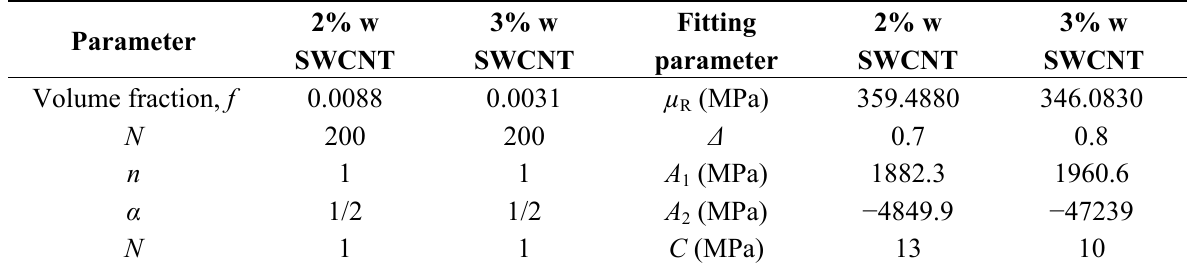
Table 6. Entry and fitted parameters values for PC/ABS-SWCNT composite material.